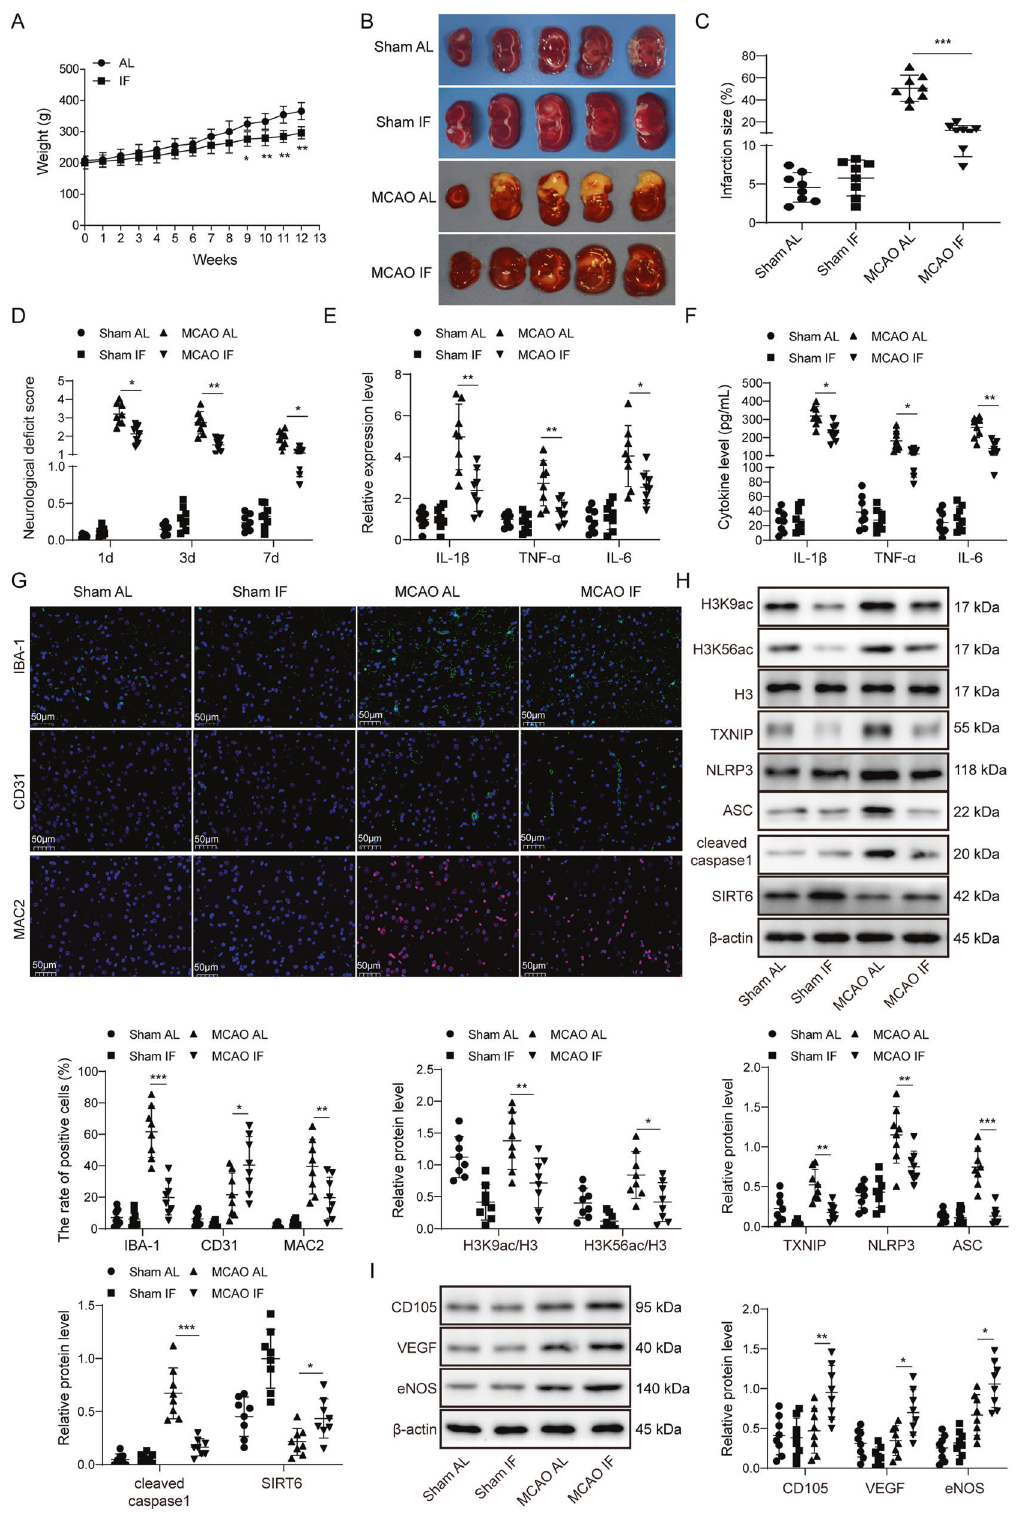
Fig. 1 IF protects against cerebral ischemia-induced impairment, microglial activation, and potentiated MCAO-induced angiogenesis. A The body weights of rats. B TTC stained sections illustrating normal (red) and infarct area (white). C The size of infarct area was expressed as percentage (%) of brain volume. D Neurological de fi cit scores using Longa scoring system. E The mRNA levels of cytokines in brain tissues were determined by qRT-PCR. F The serum levels of cytokines were detected by ELISA assay. G Immuno fl uorescence staining of IBA-1 (Green), CD31 (Green) and MAC2 (Red) in the peri-infarct cortex. Blue, DAPI. Scale bar = 50 μ m. H , I The protein levels of target proteins were determined by Western blotting. β -actin acted as a loading control for Western blotting. For animal studies, n = 8/group. * p < 0.05, ** p < 0.01, and *** p <